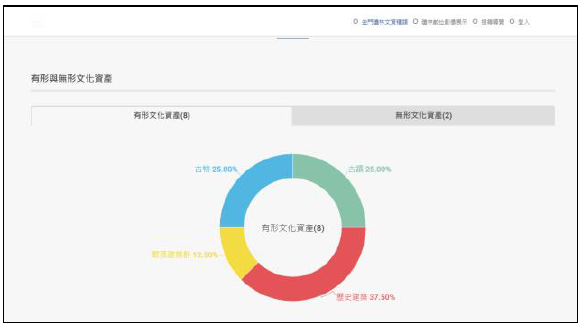
Figure 7. Statistics function of system